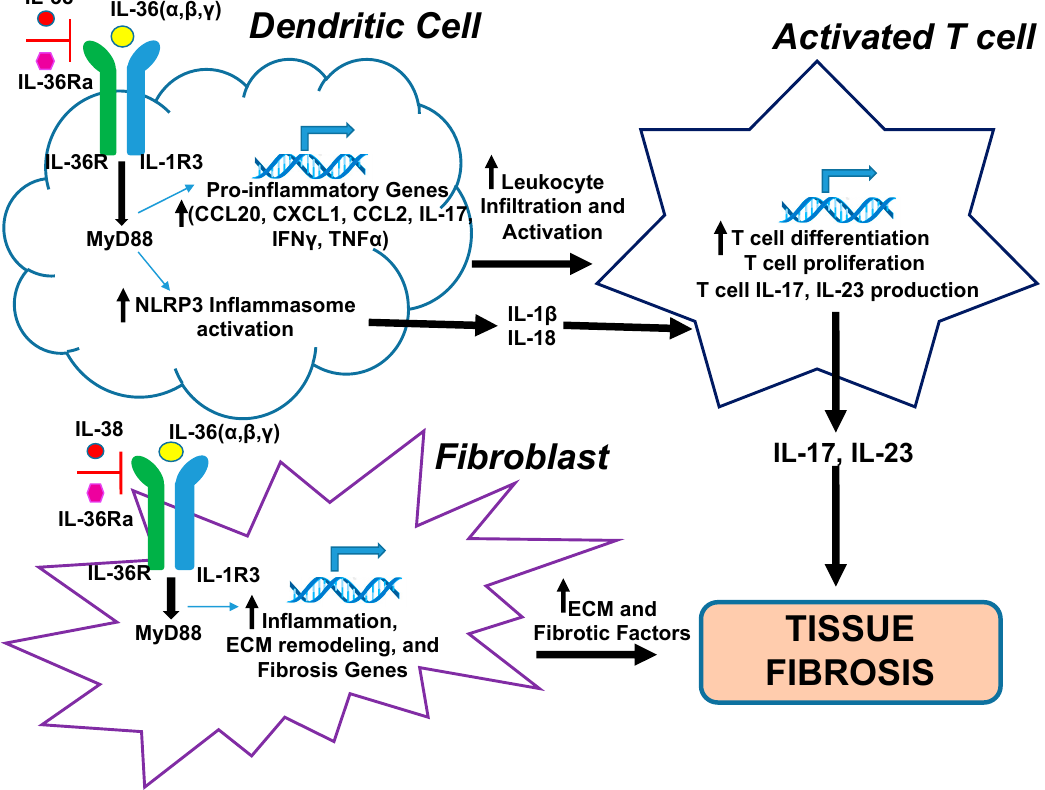
Figure 3. Potential molecular mechanisms of IL-36R induced tissue fibrosis. IL-36R signaling promotes fibrosis development in tissues by (1) regulating dendritic cell and T cell immune responses through a MyD88 dependent pathway and (2) driving inflammation, extracellular matrix (ECM), and fibrogenic gene upregulation in fibroblasts. Nod-like receptor family pyrin domain containing 3 (NLRP3).